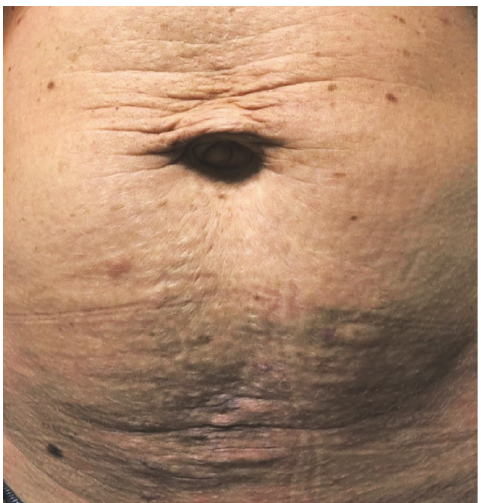
Figure 3: Catheter-based venogram confirmed May-Thurner anatomy with sequelae of chronic DVT in the left iliac vein and cross-pelvic drainage via pelvic and abdominal wall varices (red arrows).